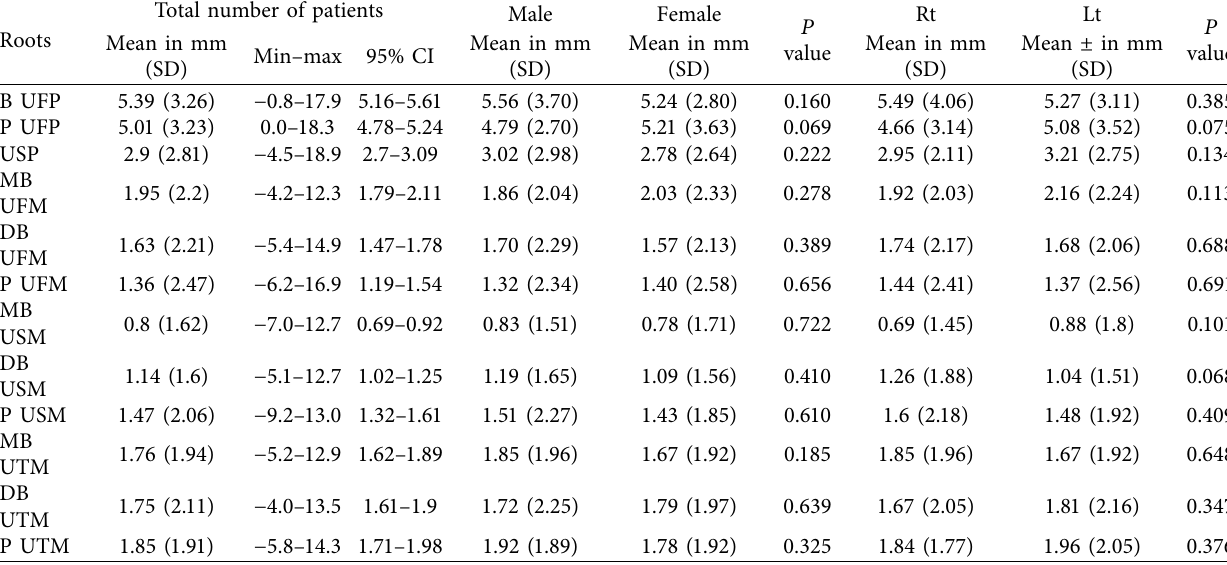
Table 1: Mean distance of different maxillary posterior roots from MSF among the studied sample.